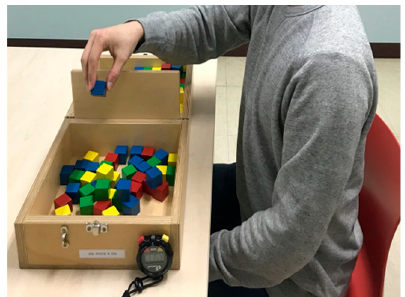
Figure 1. Conventional BBT. Analysis of hand motion of post-stroke hemiplegia patients.